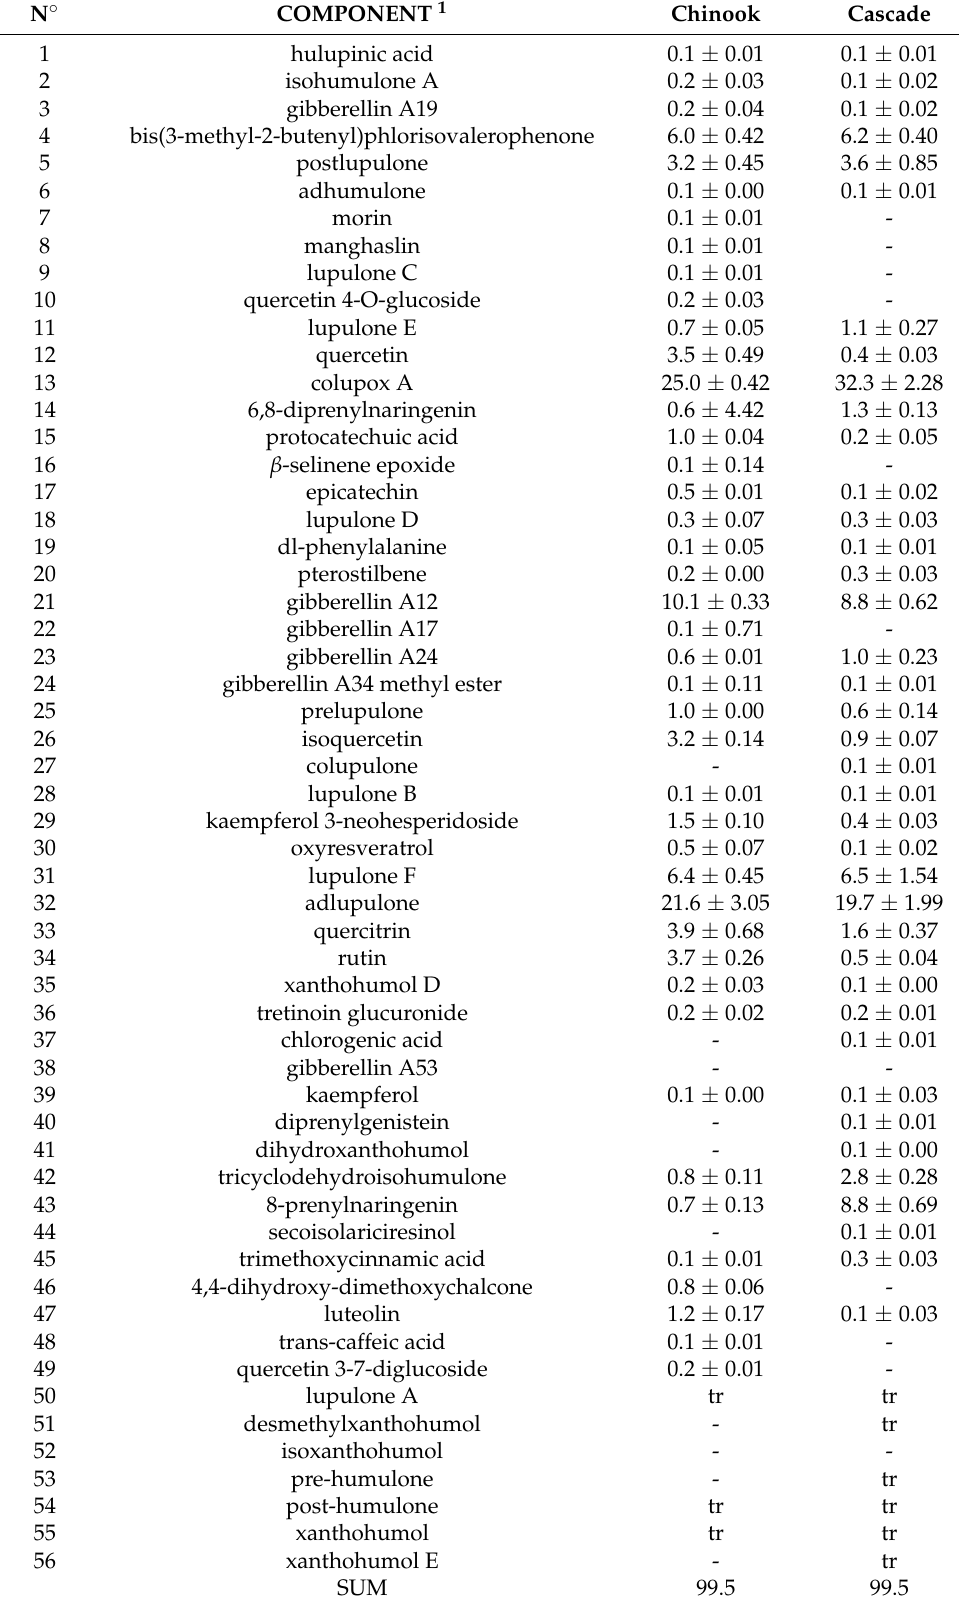
Table 2. Chemical non-volatile composition (percentage mean value ± standard deviation) of Humulus L.